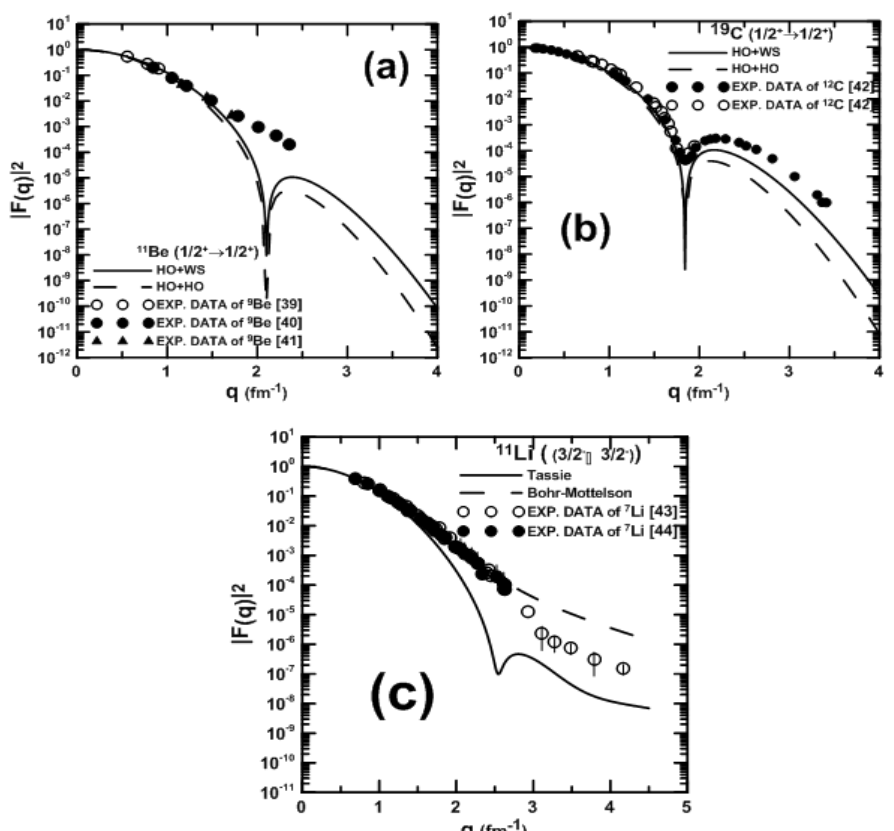
Fig. 2: The calculated charge form factors for halo 11 Be, 19 C and 11 Li nuclei compared with stable 9 Be, 12 C and 7 Li